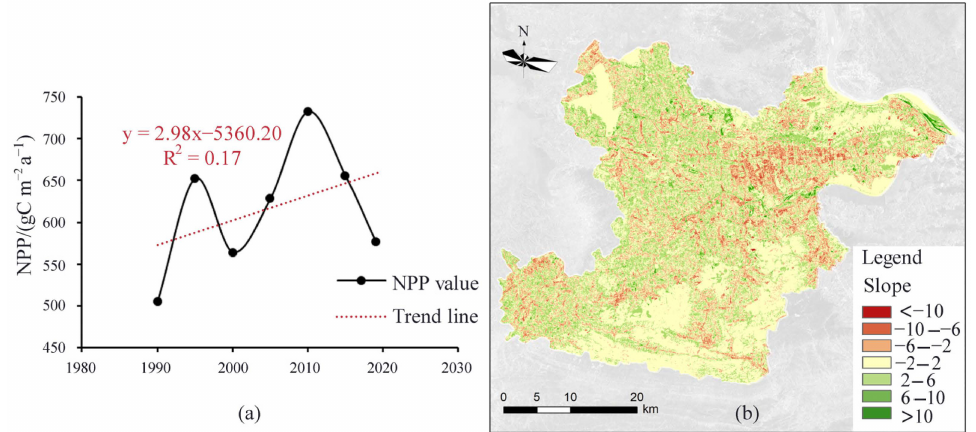
Figure 4. The NPP change trend of the study area from 1990 to 2018 ( a ), the spatial distribution of the NPP change trend from 1990 to 2018 at the pixel scale ( b ). Note: In order to quantify the dynamic of NPP, we used a least-square linear regression model to fit it. The change trend is described by the modeled slope, which is a of the y = ax + b . The red dotted line is the trend line of NPP, and the change trend is +2.98 gC m − 2 a − 1 per